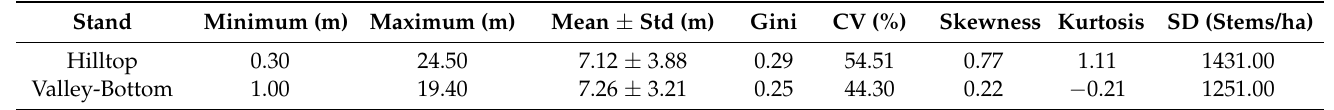
Table 2. Statistics of the height distributions of the Teak stand in Valley-Bottom and Hilltop in the Coefficient of Variation; CV, Gini-Coefficient; Gini, Skewness-coefficient; Skewness. Omo Forest Reserve. Additionally, the mean of the stem height of the Hilltop stand was not significantly different from the mean height of the Valley-Bottom stand (7.12 ± 3.88 vs. 7.26 ± 3.21 m; t -test = 0.67, p = 0.500). The stem height distribution of the Hilltop and Valley-Bottom